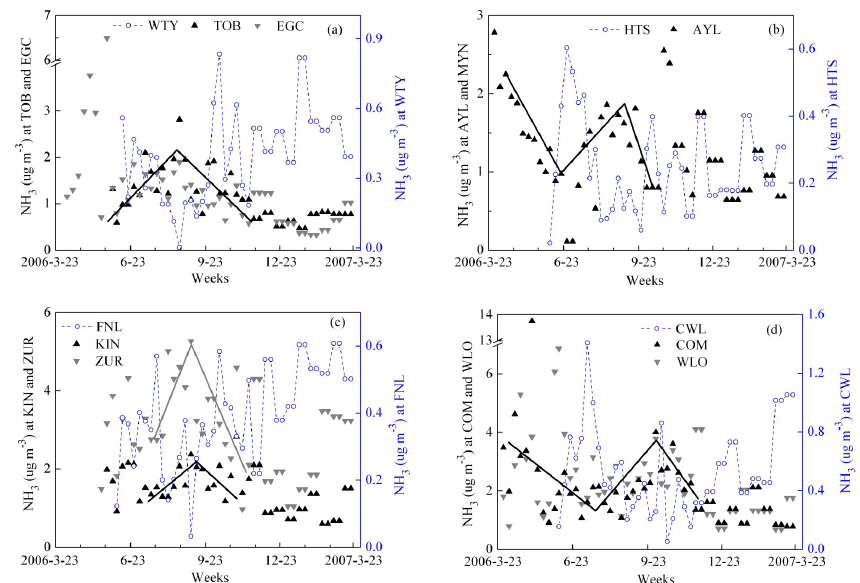
Fig. 7. Comparison of time series of NH 3 concentration between southwestern and southeastern sites (the straight lines are trend lines artificially drawn).